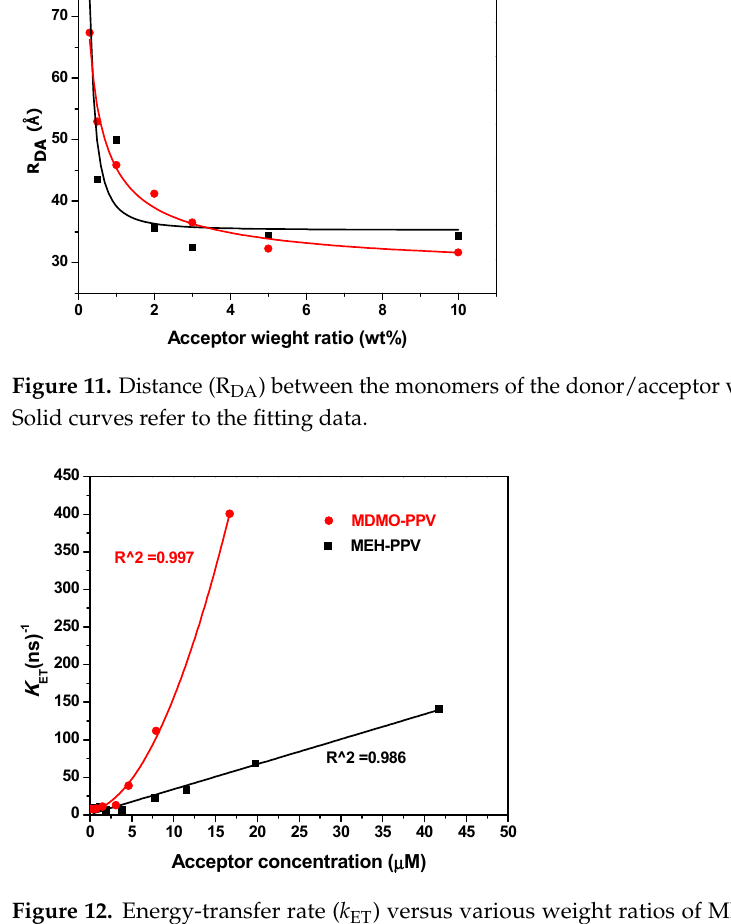
Figure 13. ( a ) Energy-transfer probability (P DA ) and ( b ) energy-transfer efficiency ( η ) from PFO to each MEH-PPV and MDMO-PPV–DMP. Solid curves refer to the fitting data.